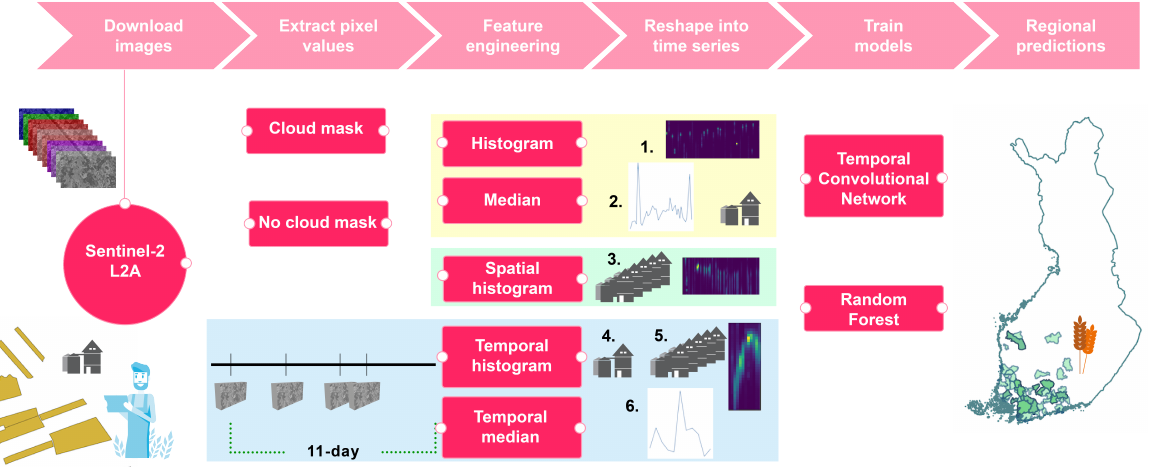
Figure 9. Processing pipeline to predict crop yield from satellite time series data. Six object repre- sentation schemes were applied as an input to temporal convolutional network and random forests. Object representation schemes were repeated with cloud-masked and not cloud-masked data. Models were trained at both farm-level and regional-level for comparison. Regional predictions were either mean-aggregated from farm-level predictions or taken from regional-level